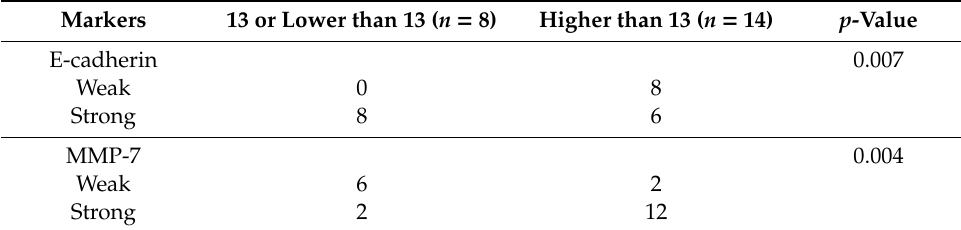
Table 1. Expressions of E-cadherin and MMP-7 according to reflux symptom index. Markers 13 or Lower than 13 ( n = 8) Higher than 13 ( n = 14) p -Value E-cadherin 0.007 Weak 0 8 Strong 8 6 MMP-7 0.004 Weak 6 2 Strong 2